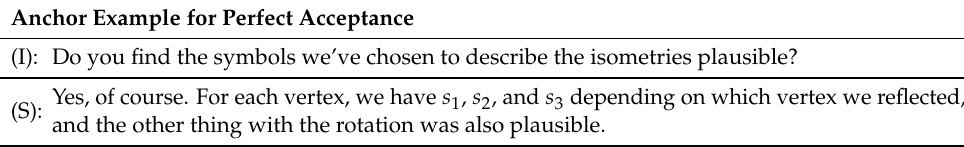
Table 4. Perfect acceptance of Participant D and A1-2 (cf. Table A3 in the Appendix A). Anchor Example for Perfect Acceptance